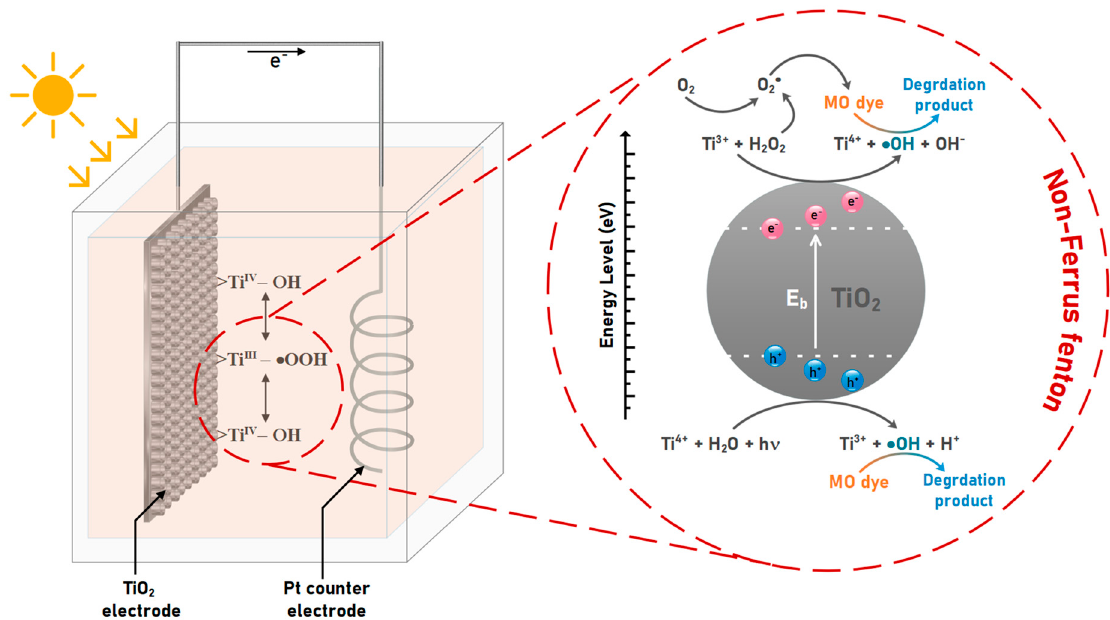
Figure 5. ( Left ) Experimental setup and ( right ) proposed reaction pathway.